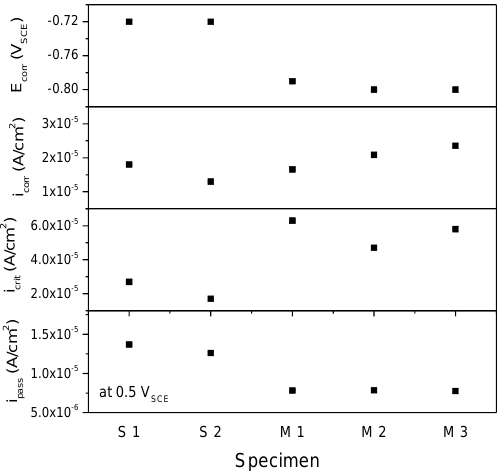
Figure 5. Potentiodynamic polarization curves.